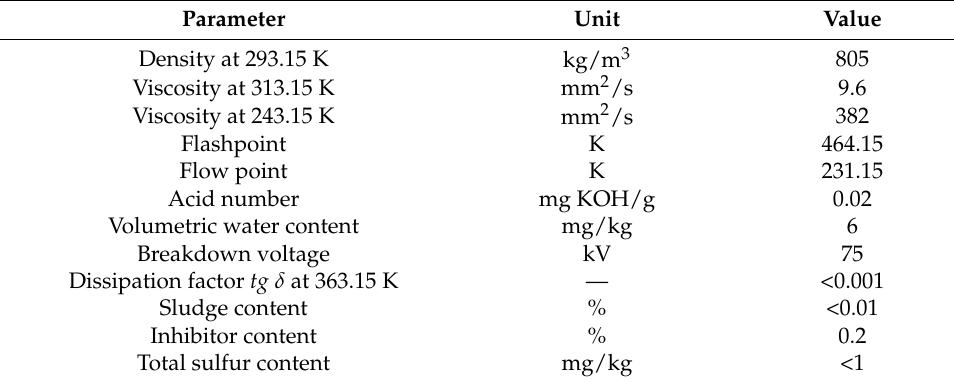
Table 2. Characteristic parameters of SD oil. Adapted from [17].